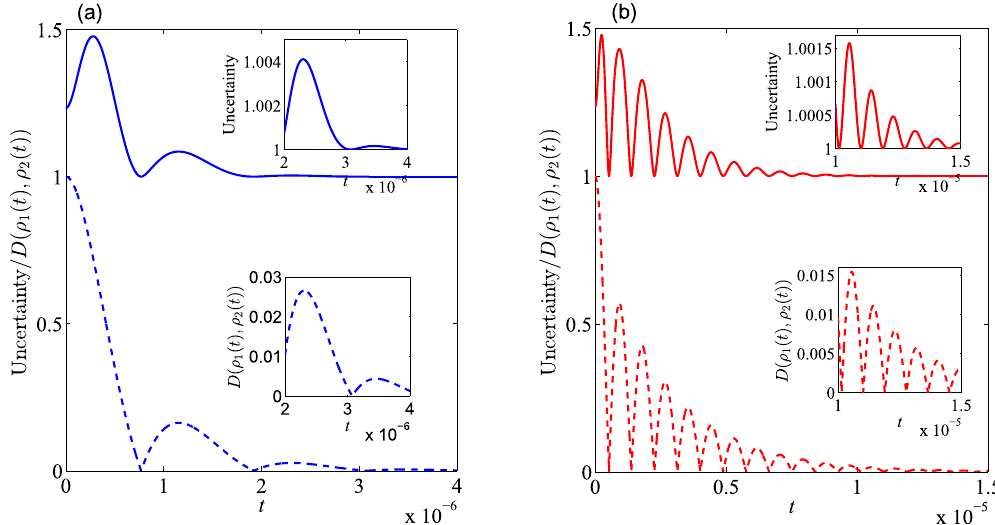
Figure 2. The trace distance, ρ ρ D ( , ) , and entropic uncertainty as a function of t for an initial state constructed 1 2 with θ π = /4 and φ π = /8 ; we have set π Ω = Θ = × 10 6 Hz. In Graphs (a,b), γ = Ω 1000 and γ = Ω , respectively. Within each graph, the solid line represents the uncertainty while the dashed line represents the trace distance in the two